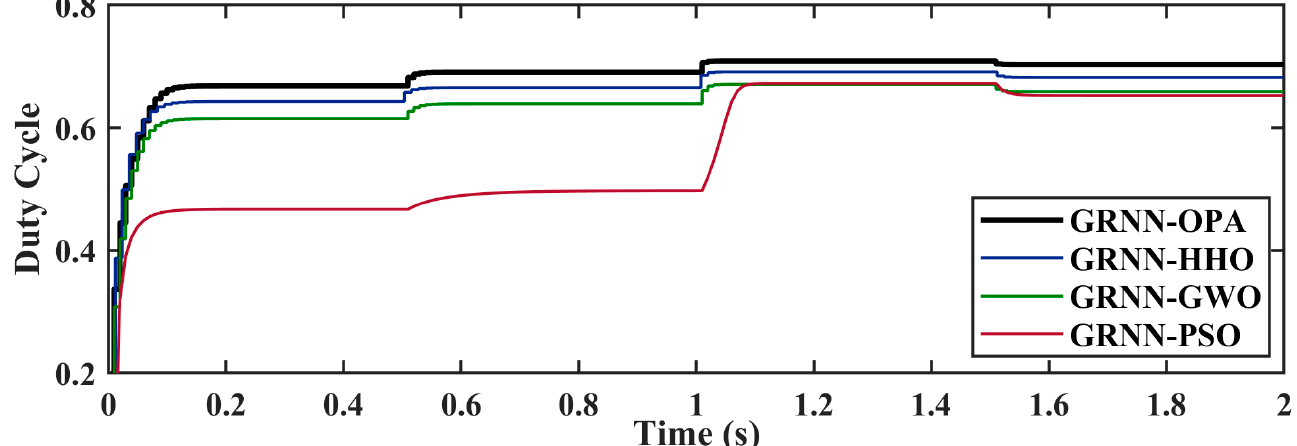
Figure 10. Comparison of power tracked in case 2.